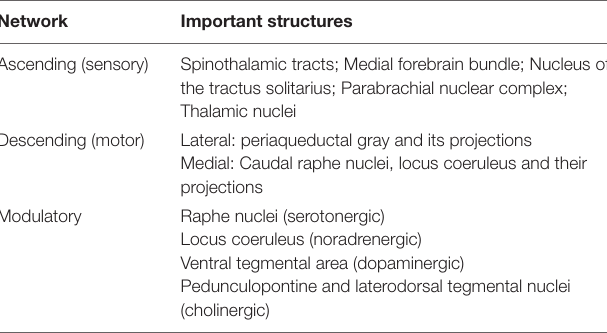
TABLE 1 | The three networks of brainstem structures involved in emotion processing, and their components.